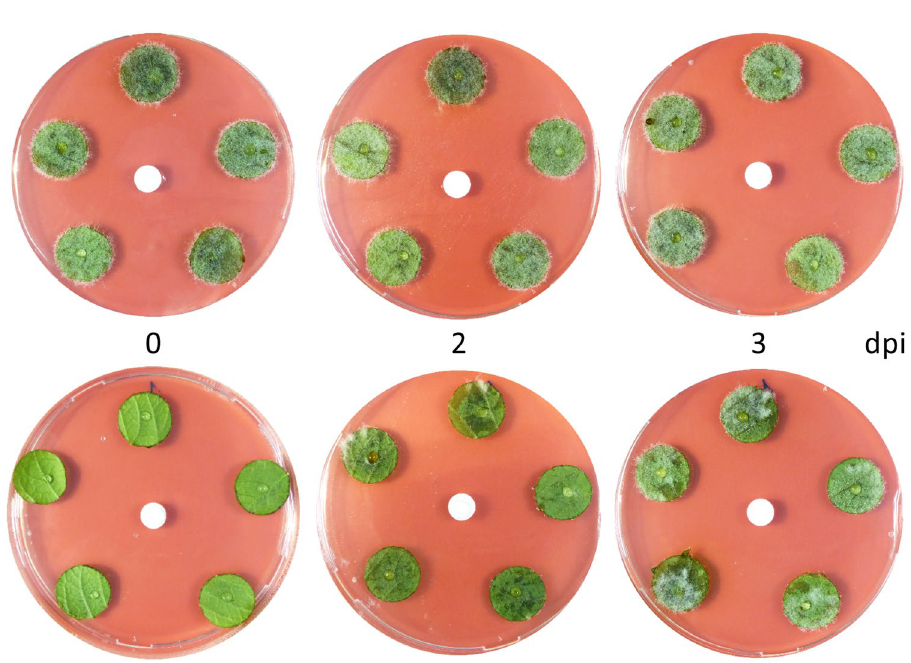
Figure 3. MMTS protects potato leaf discs against late blight when applied post infection. Leaf discs were infected with P. infestans at day 0 and further treated with solvent (upper panel) or 1 mg MMTS (lower panel) at 0, 2 and 3 days post infection (dpi). Pictures are shown after six days of incubation and are representative of three technical replicates. The biological experiment was repeated